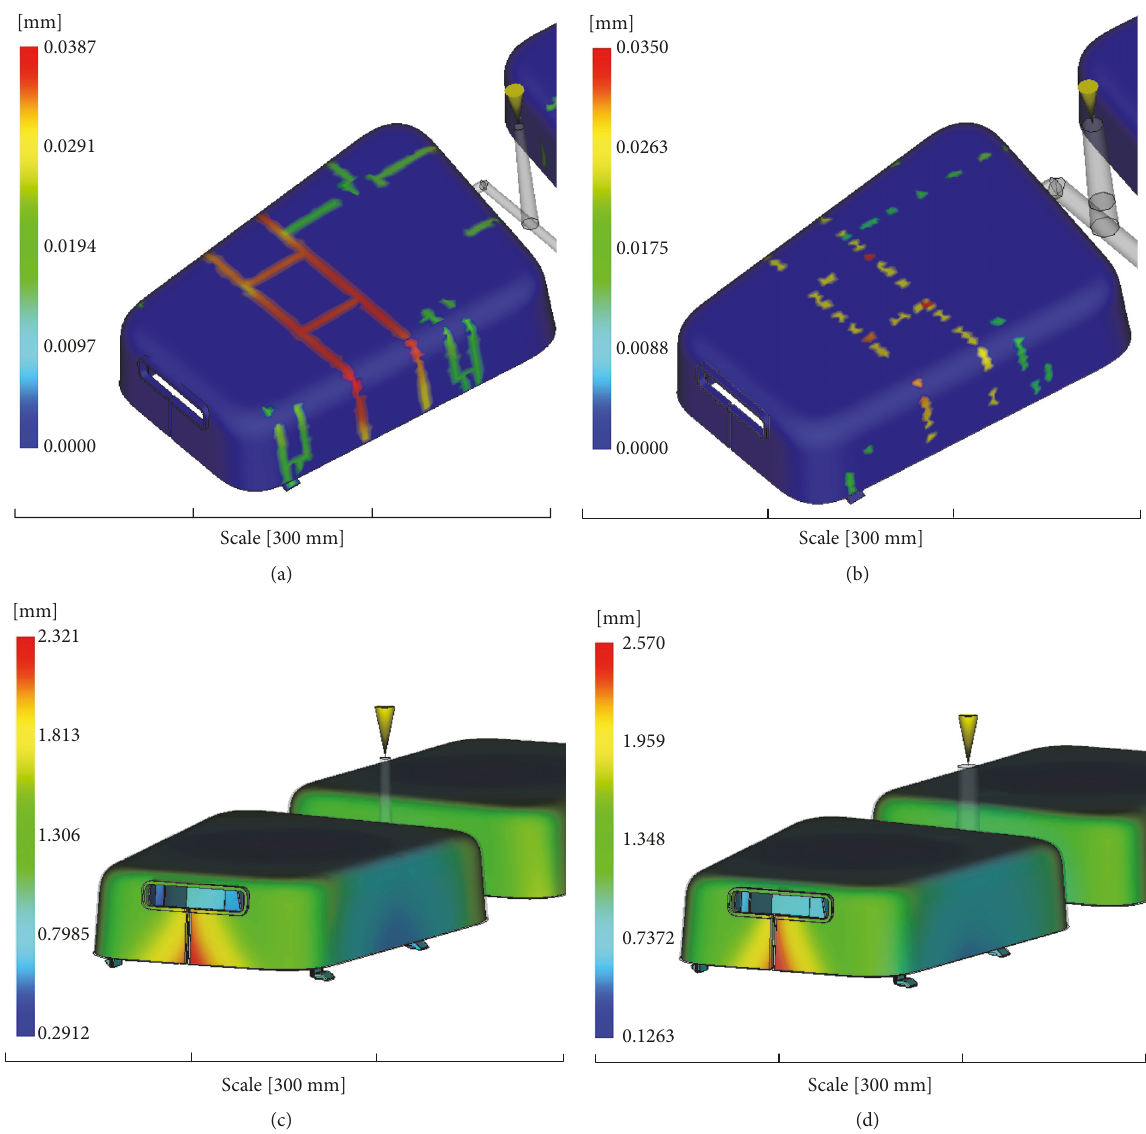
Figure 7: Contours of sink marks and warpage: (a) sink marks of Case No. 6, (b) sink marks of Case No. 16, (c) warpage of Case No. 6, and (d) warpage of Case No.